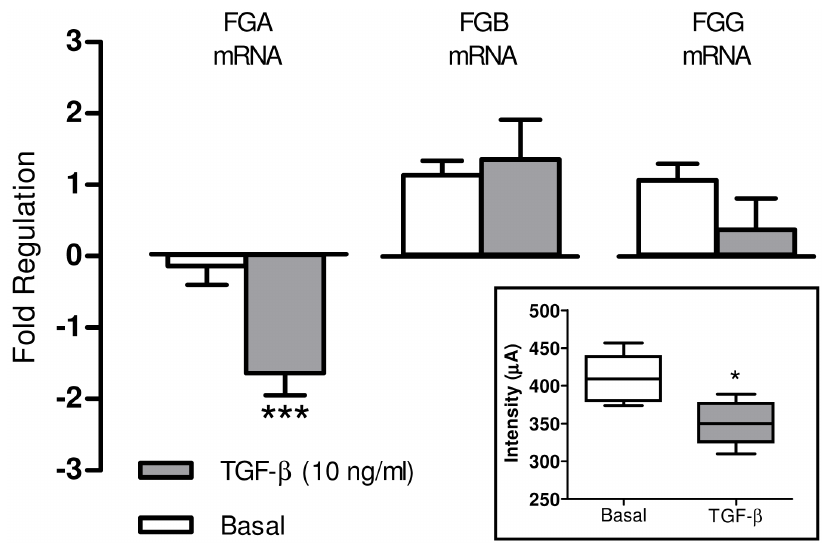
Figure 5. TGF- b reduces the fibrinogen a -chain expression in HepG2 cells. Fold regulation in Fibrinogen Alpha Chain (FGA), Beta Chain (FGB) and Gamma Chain (FGG) genes regulation in HepG2 cells after 6 hours of treatment with TGF- b (10 ng/ml). Results are given as mean 6 SE; ***p , 0.001 vs. basal. Statistical analysis was calculated by unpaired Student’s t test. The insert shows the intensity values of the 5.9 kDa peak detected in the cellular supernatant of HepG2 cells after 48 hours of treatment with TGF- b (10 ng/ml). Results are given as mean 6 SE; *p , 0.05 vs. basal. Statistical analysis was calculated by Mann-Whitney U test.